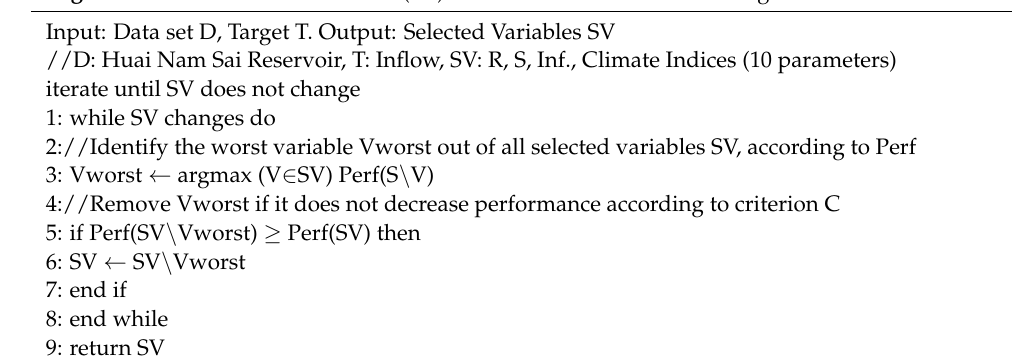
Algorithm 1 Backward Elimination (BE) for Reservoir Inflow